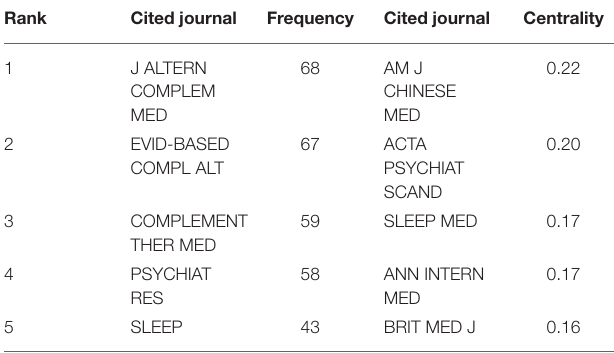
TABLE 2 | Top 5 cited